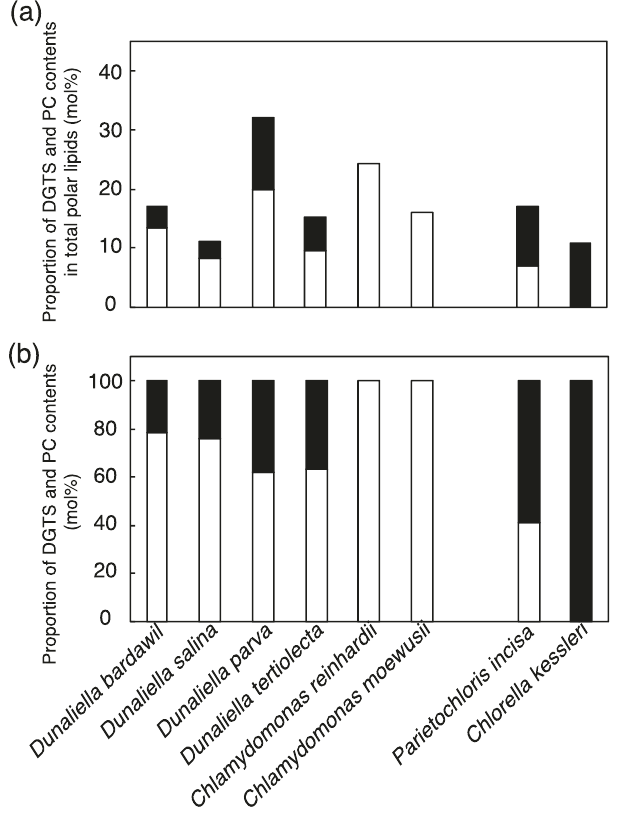
Fig. 1 DGTS and PC contents in green algae grown under + P conditions. a Respective contents of DGTS and PC relative to that of total polar lipids. b The proportion of DGTS and PC contents. White and black bars indicate the contents of DGTS and PC, respectively. The values were obtained from previous reports 10 – 15, 17